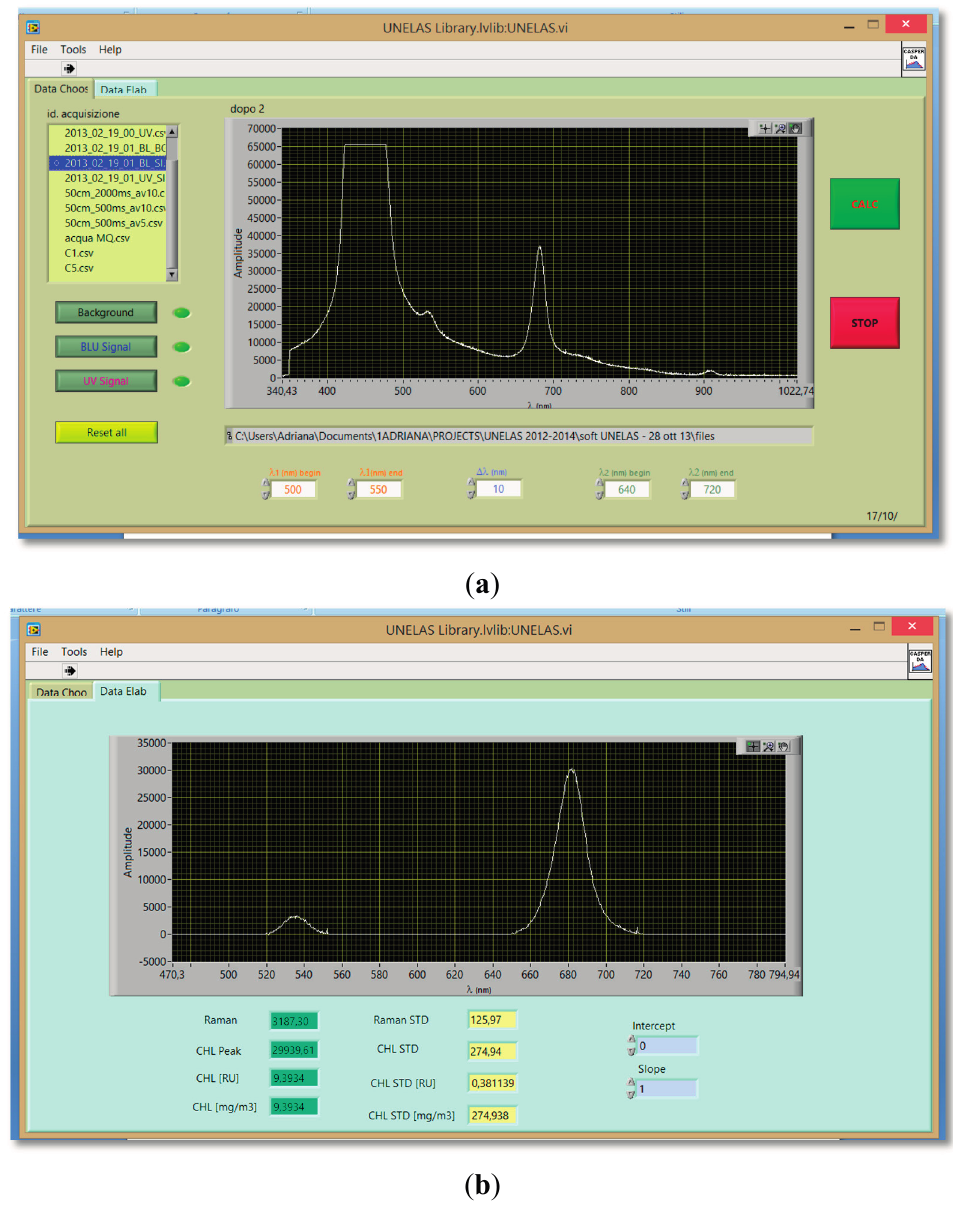
Figure 9. Panel of the data processing software showing: ( a ) unprocessed spectra; ( b ) results of the automatic data